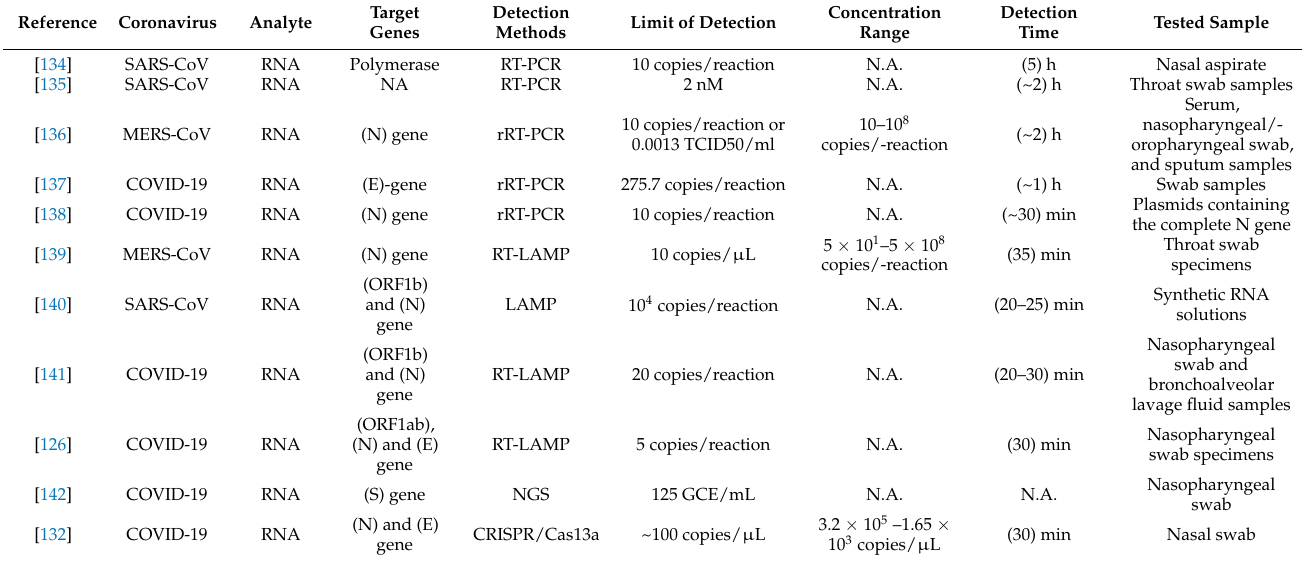
Table 3. RNA Coronavirus detection methods analysis based on RT-PCR, LAMP, NGS and